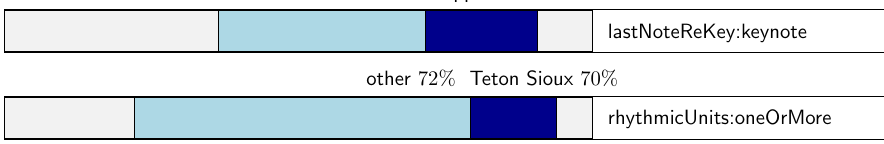
Figure 1. Visualization of two example patterns from Densmore’s quantitative analyses. Top: Songs of the Chippewa ending on the keynote, compared against combined Sioux, Ute, Mandan, Hidatsa, Pawnee, Papago, and Menominee songs. Bottom: Songs of the Teton Sioux containing one or more rhythmic units, compared against combined Chippewa, Ute, Mandan, Hidatsa, Pawnee, Papago, and Menominee songs. The bar charts show the relative frequency of the pattern in the target class (dark blue) and the background of other classes (light